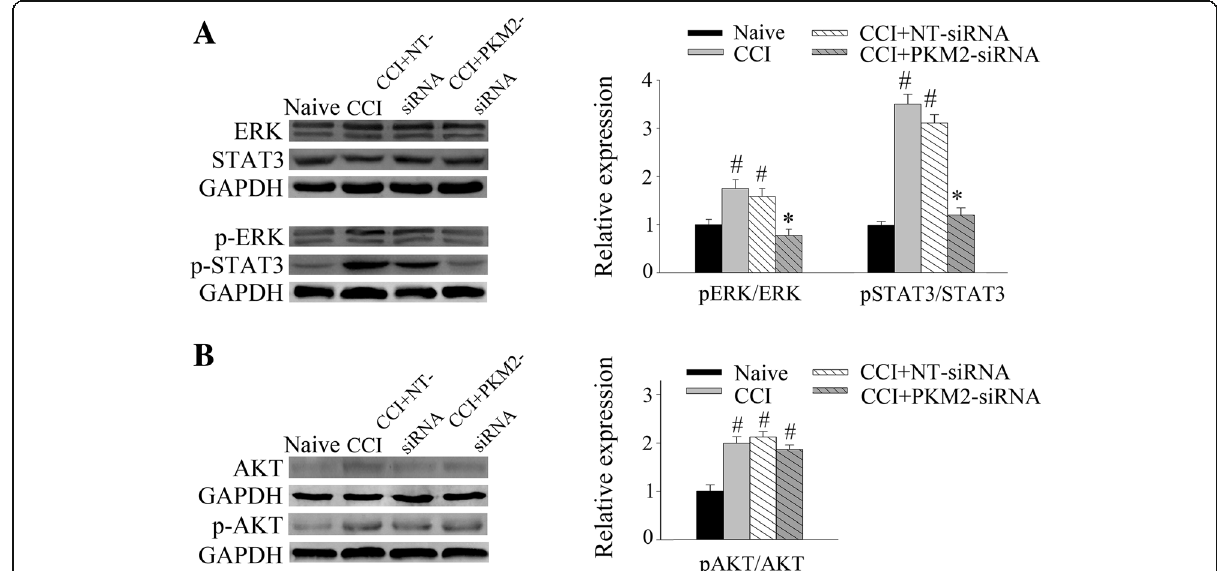
Fig. 4 PKM2 siRNA reversed the phosphorylation of ERK and STAT3 in the spinal cord L4 – 5 segments induced by CCI. Western blot was performed to evaluate the levels of phosphorylated ERK, STAT3, and AKT in protein extracted from the L4 – 5 segment of spinal cord in each group. GAPDH was used as an internal control. a Treatment with PKM2 siRNA significantly reduced the pERK/ERK and pSTAT3/STAT3 ratios. * P <0.05 versus NT siRNA group. # P <0.05 versus naïve group. Four rats per group. b PKM2 siRNA failed to inhibit the phosphorylation of AKT. # P <0.05 versus naïve group. Four rats per